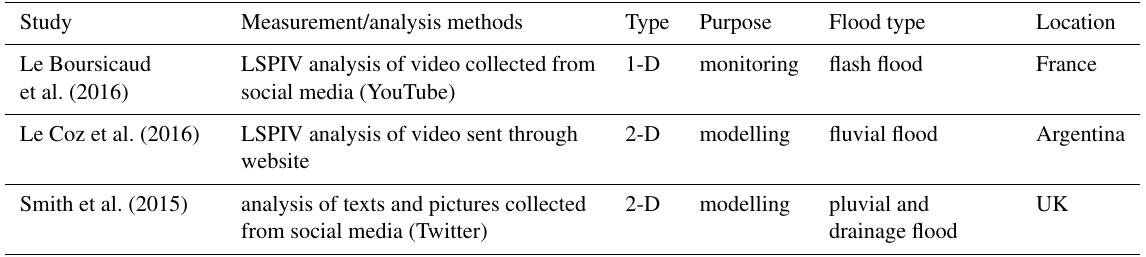
Table 2. Scientific literature on citizen contributions to measurement and analysis of velocity.